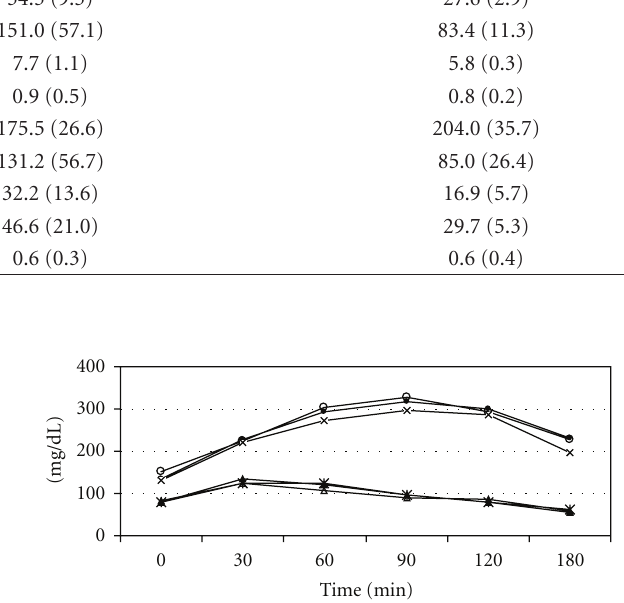
Figure 1: Mean serum glucose level at timed intervals during glucose tolerance test for 10 diabetic and 10 healthy participants. Mean serum glucose levels in mg/dL without (o) and with 125 ( • ) and 250mg ( × ) ingestion of Tinospora crispa diabetic participants, and without ( (cid:2) ) and with 125 ( (cid:3) ) and 250 mg ( ∗ ) ingestion of Tinospora crispa in healthy